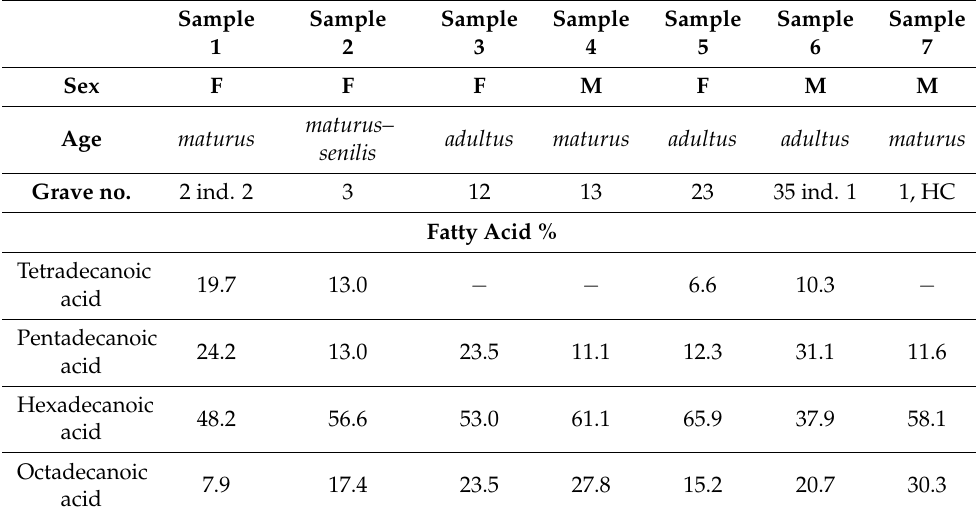
Table 1. Fatty acids detected in the analyzed dental calculus